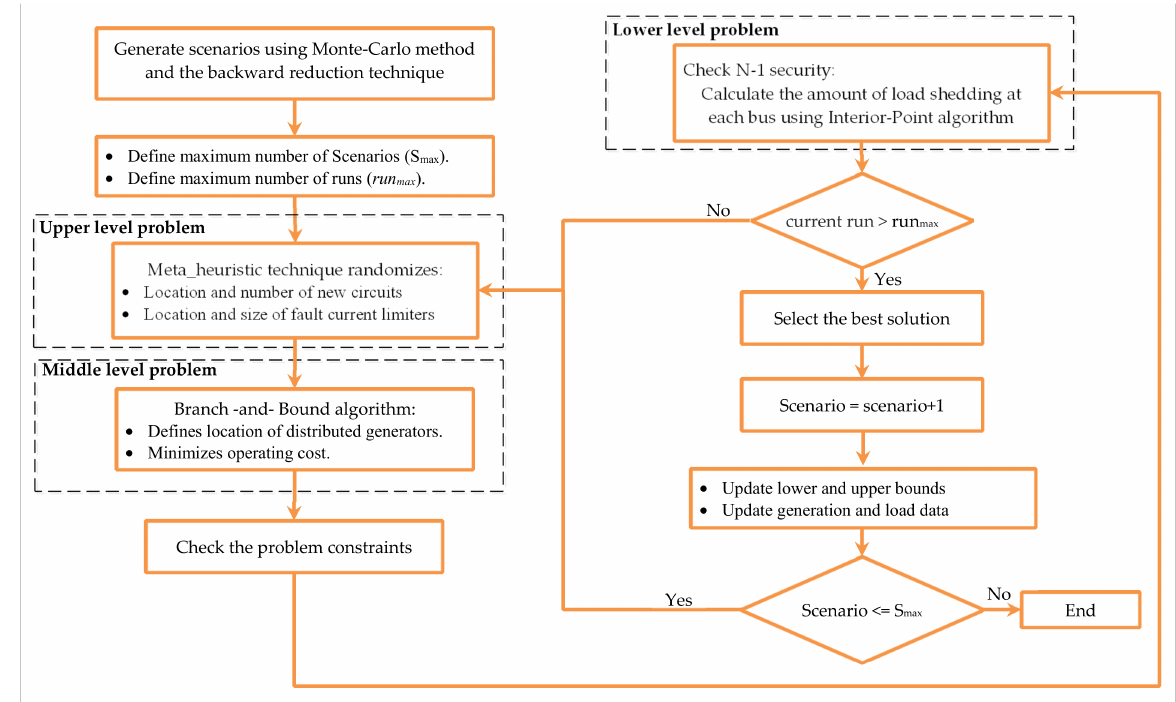
Figure 3. Proposed flowchart of G&TEP.